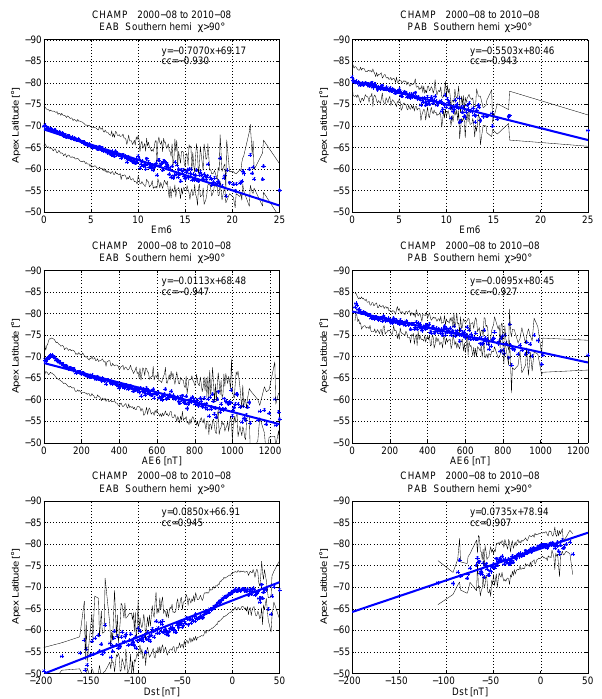
Figure 14. The same as Fig. 8, but for the Southern Fig. 14. The same as Fig. 8, but for the southern hemisphere.